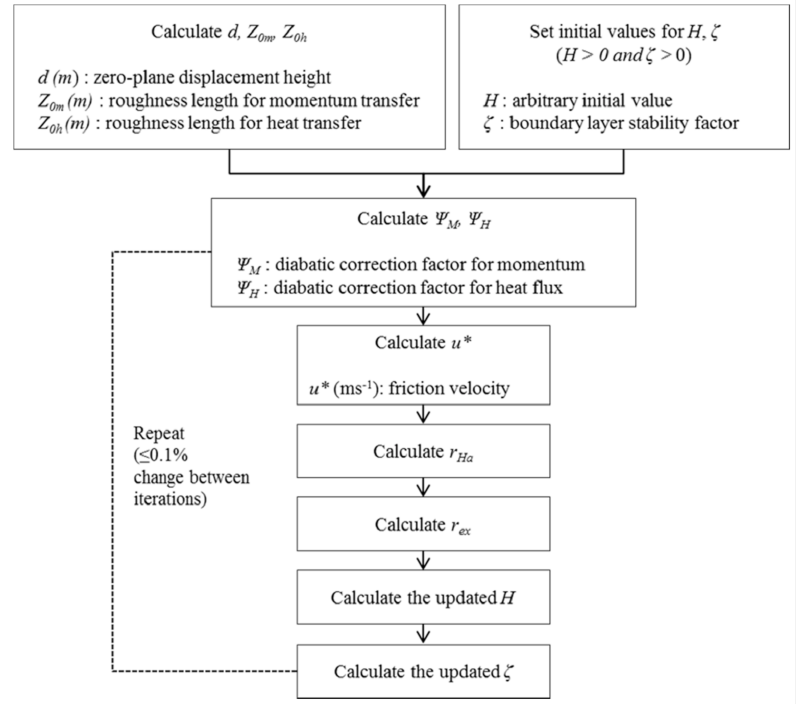
Figure 4. The iterative method of calculating sensible heat flux in the HRMET